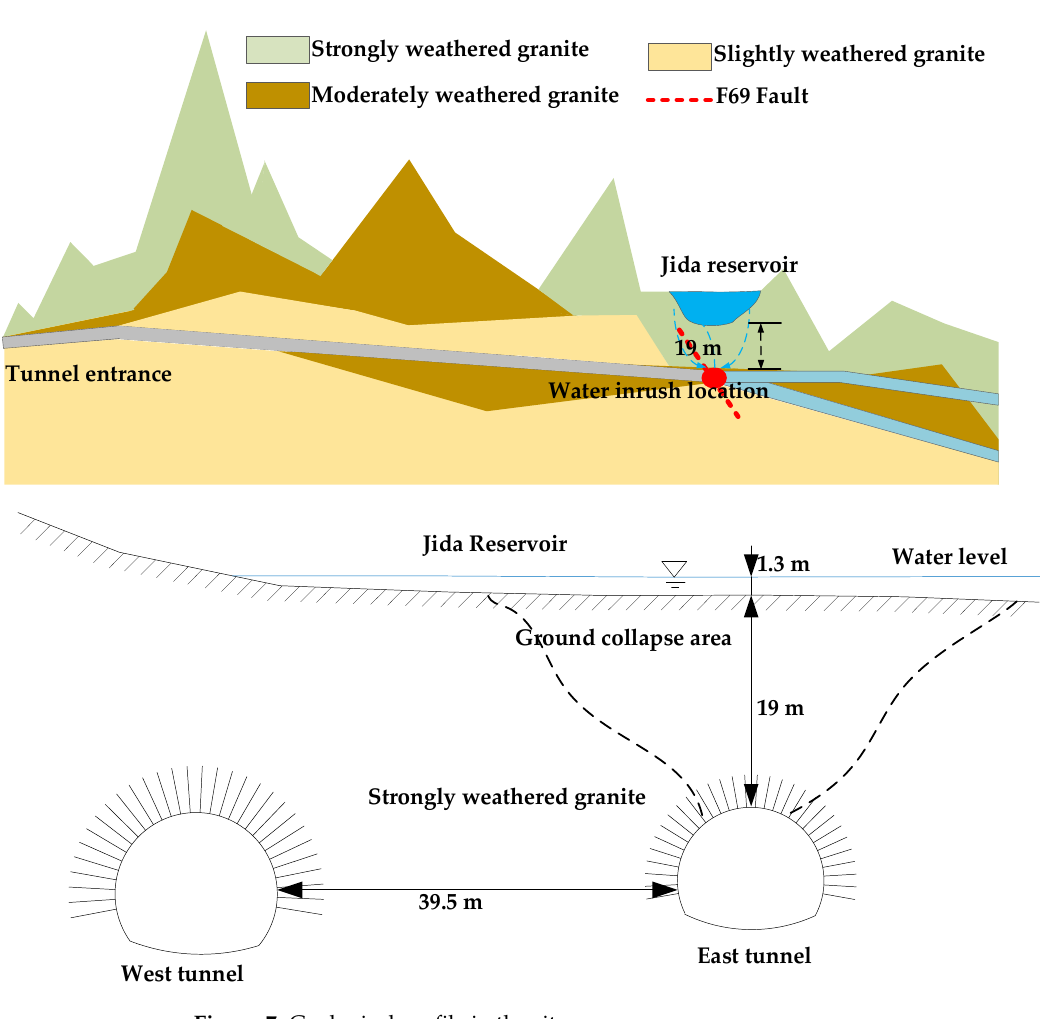
Figure 7. Geological profile in the site.